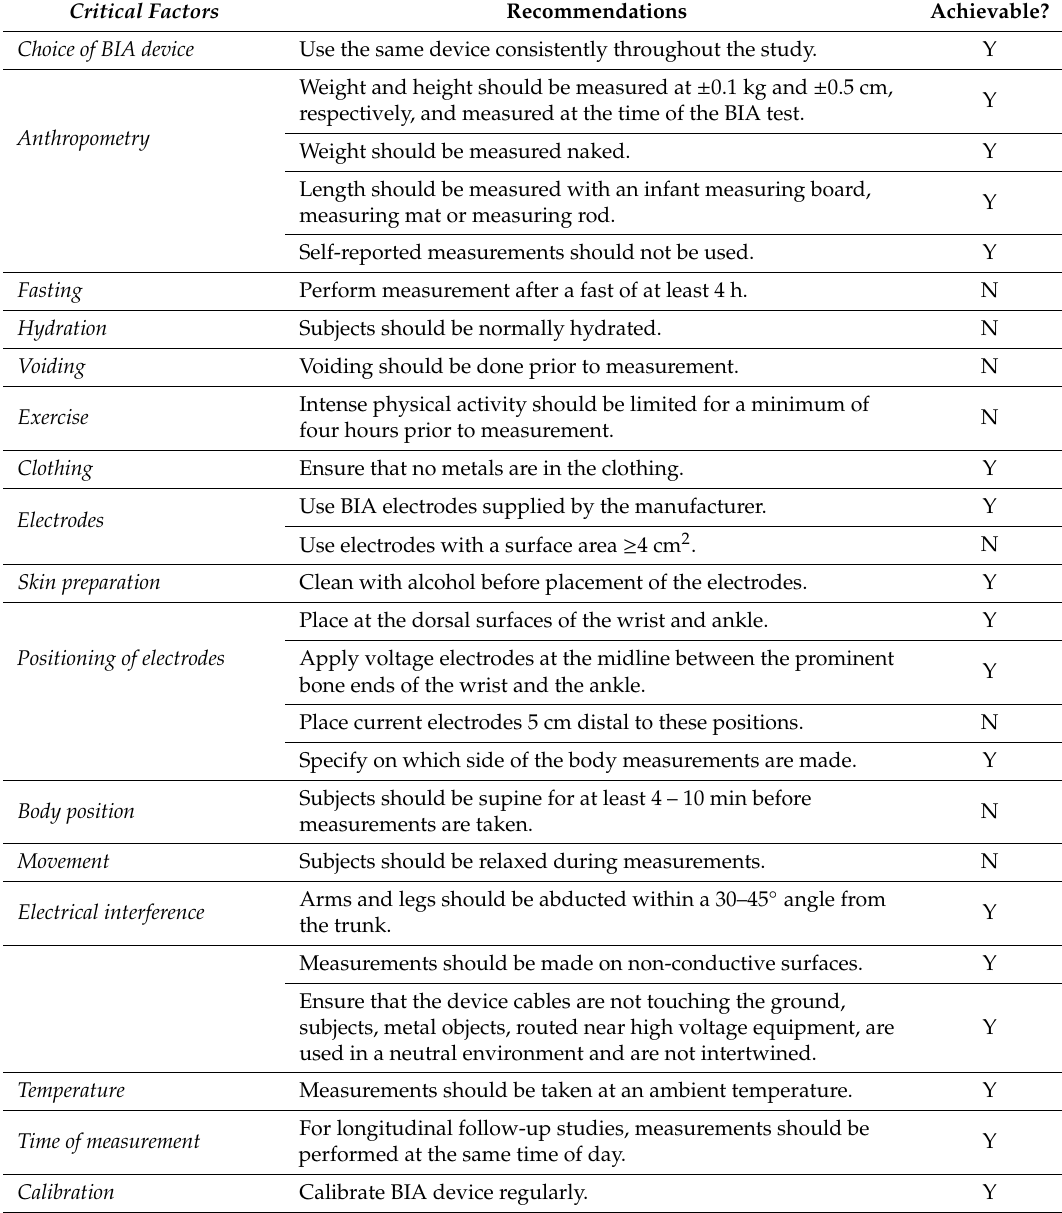
Table 1. Critical factors of bioelectrical impedance analysis in children: are they achievable in infancy? Modified from Brantlov et al.